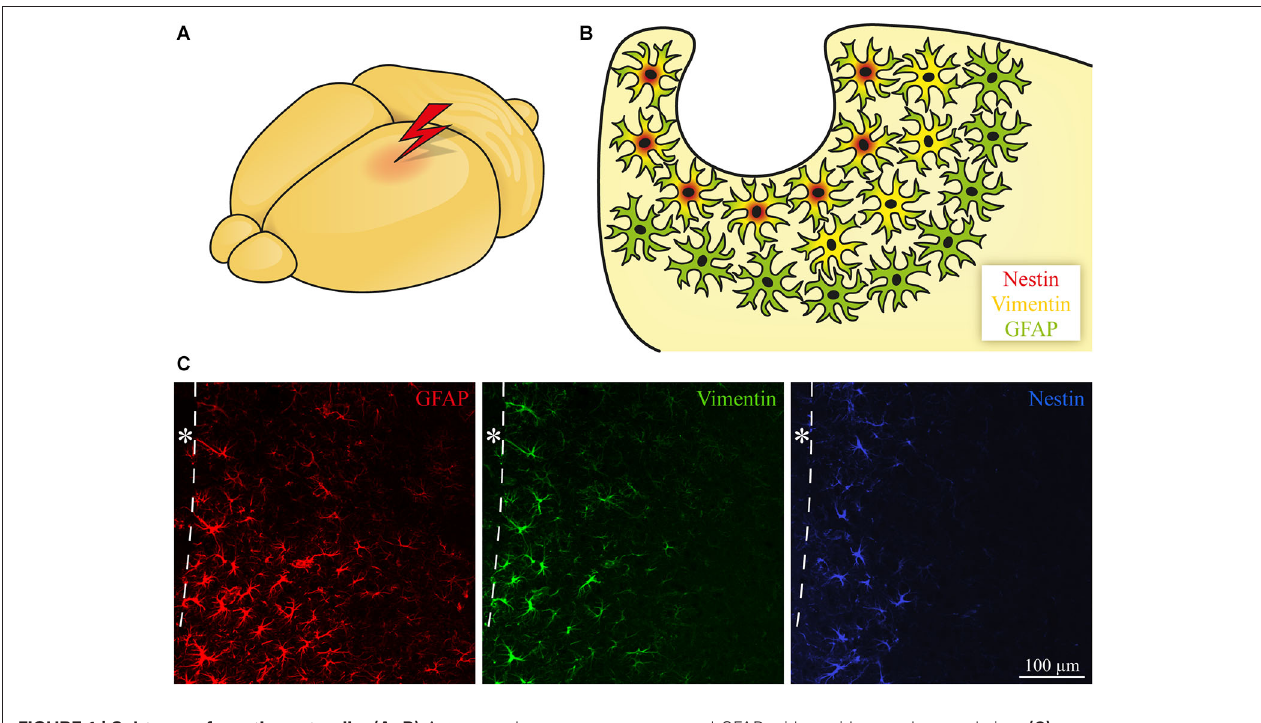
FIGURE 1 | Subtypes of reactive astroglia. (A, B) Astrocytes become reactive following CNS damage. In addition to GFAP upregulation, some of the cells start to express progenitor markers like Vimentin and Nestin. The position of the cells in relation to the lesion determines the expression pattern with Nestin near the lesion, Vimentin in a broader